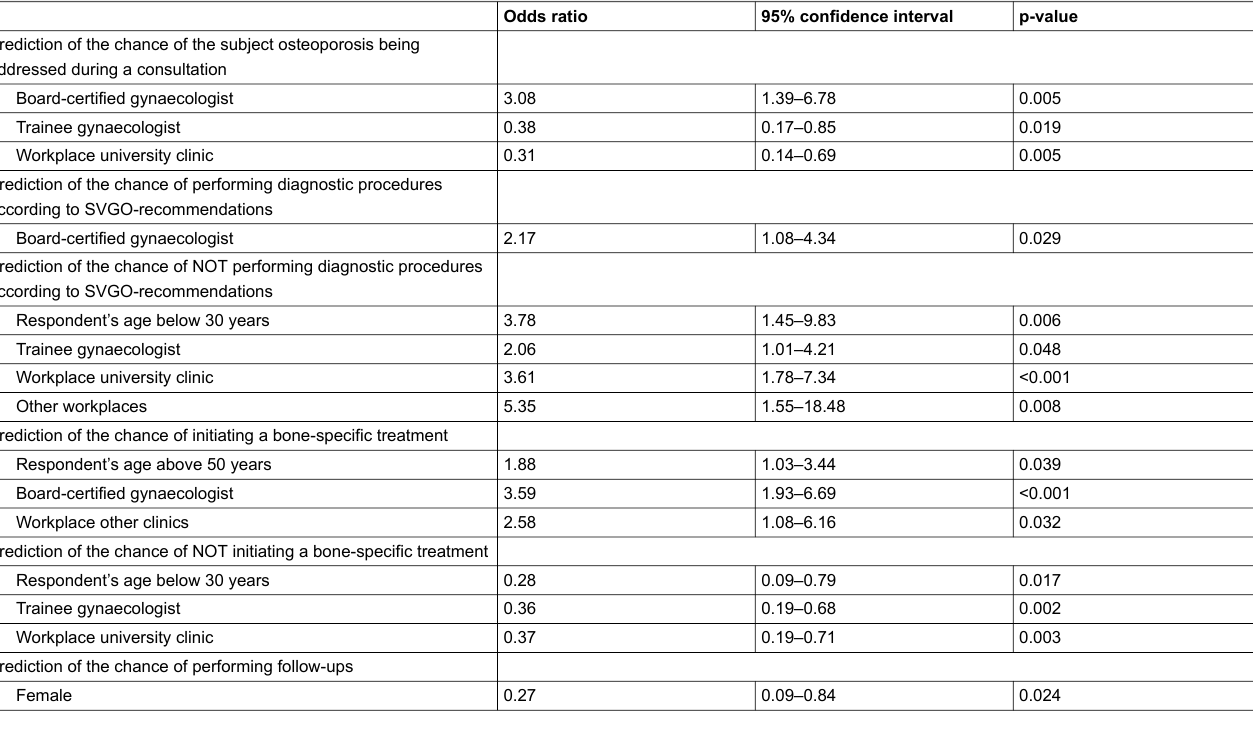
Table 2: Logistic regression analysis for prediction of the chance of the subject osteoporosis being addressed during a consultation, of (not) performing diagnostic procedures in accordance with Swiss Association against Osteoporosis (SVGO) recommendations, of (not) initiating a bone-specific treatment, and of performing follow- ups.